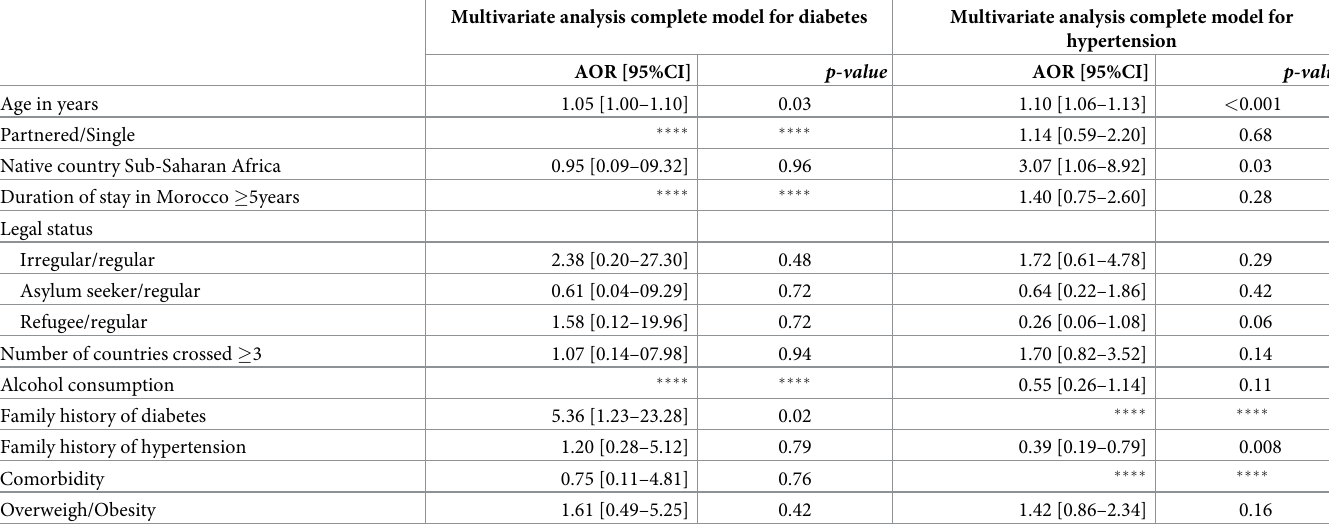
Table 3. Multivariate analysis (Odds ratio, P-value ) of diabetes and hypertension risk factors among migrants in Oujda, Morocco,